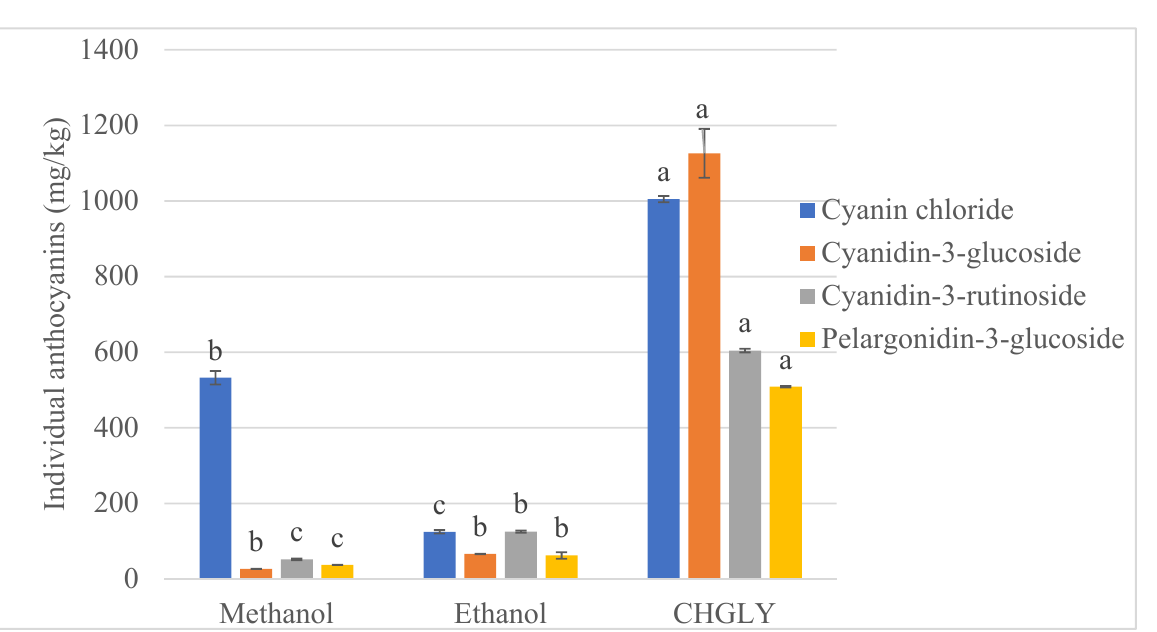
Figure 2. Individual anthocyanins extracted from borage using different solvents. a–c = Different lowercase letters on the bars with the same color indicate significant differences between solvents ( p < 0.05). Table 1. Antioxidant properties of borage extracts obtained from different solvents.